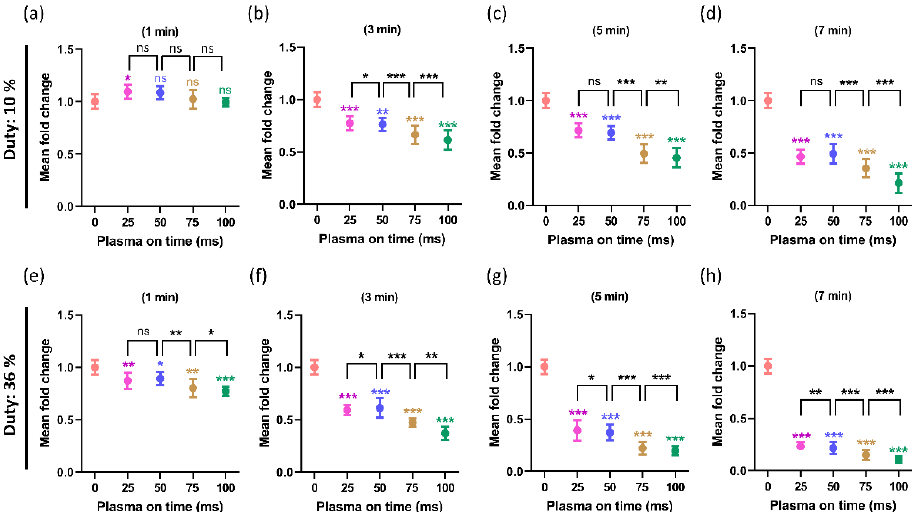
Figure 10. The intracellular ATP levels of the U87 ‐ MG cell line, which is observed 24 h after (PTM) treatment. The ATP was observed under two different duty ratios: ( a – d ) when the duty ratio was fixed at 10% and ( e – h ) when the duty ratio was fixed at 36%. It has been observed that increasing the plasma on ‐ time results in a further decline in the ATP levels of U87 ‐ MG when the duty ratio and treatment time are fixed. The significance was calculated using Microsoft Excel (MS Office 365), while the differences between the treatment groups are indicated by * p < 0.05, ** p < 0.01, *** p < 0.001, ns—not significant.